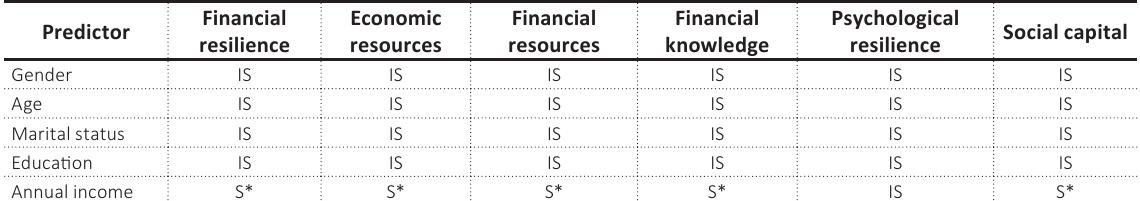
Source: Analysis of survey data.